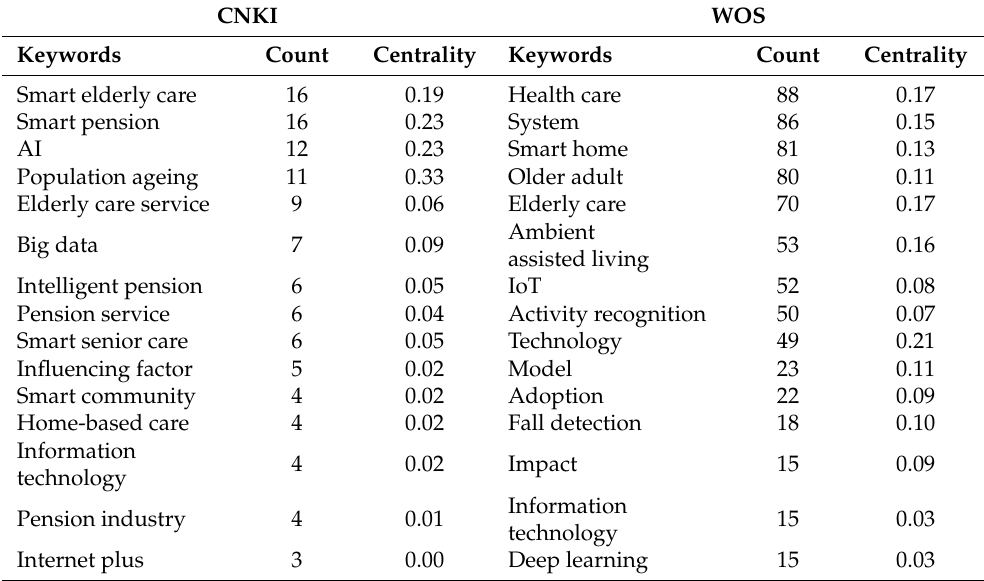
Table 8. High-frequency